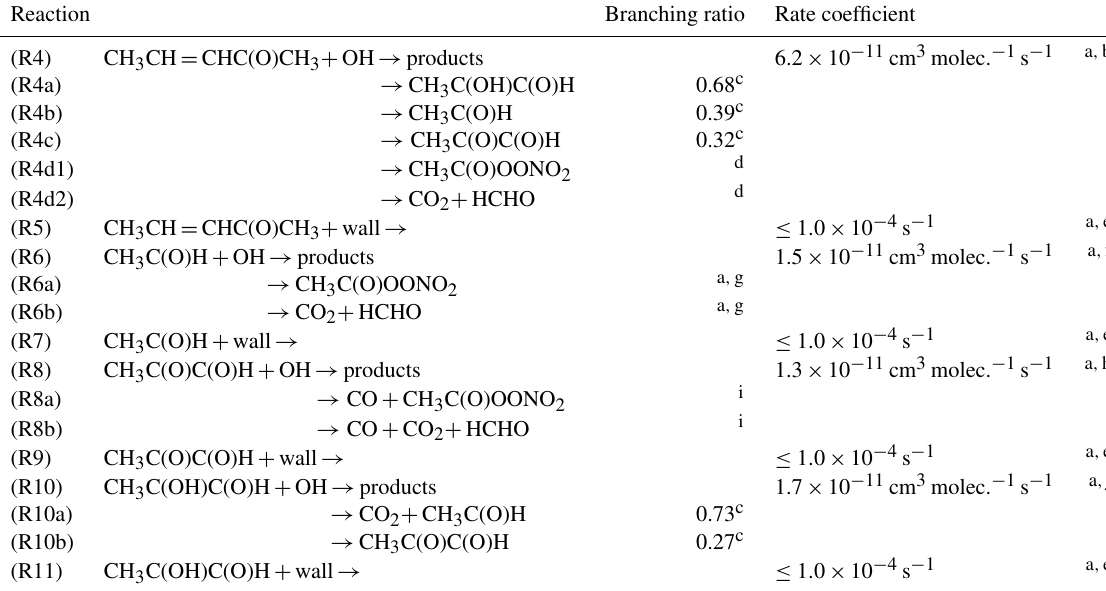
Table 2. Simplified reaction sequence used for the modelling of the temporal behaviour of experimentally quantified species in order to obtain first-generation yields for the respective reactions (3P2 + OH, 2HPr + OH).